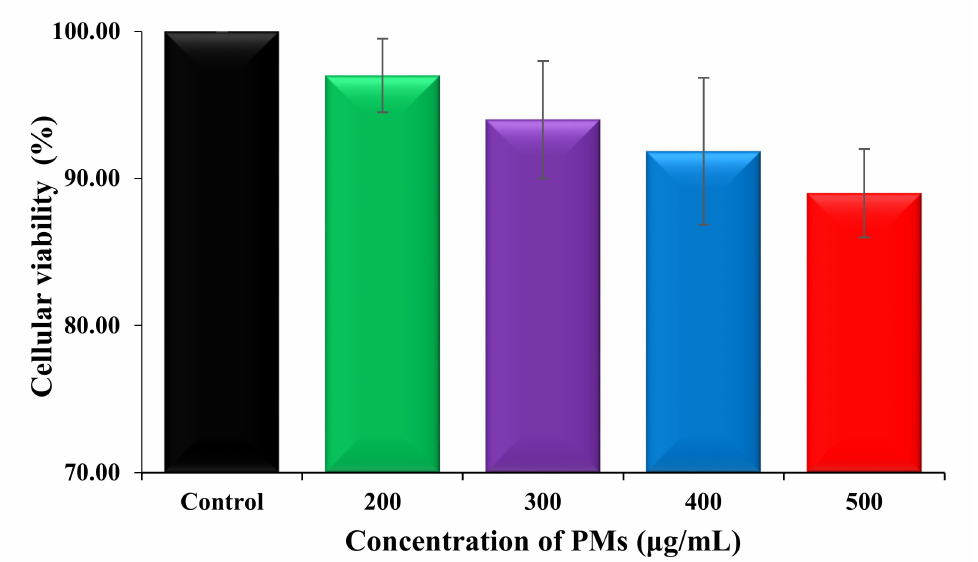
Figure 6. Evolution of the HDFa cellular viability after a treatment of 72 h with di ff erent concentrations of drug-free PMs.